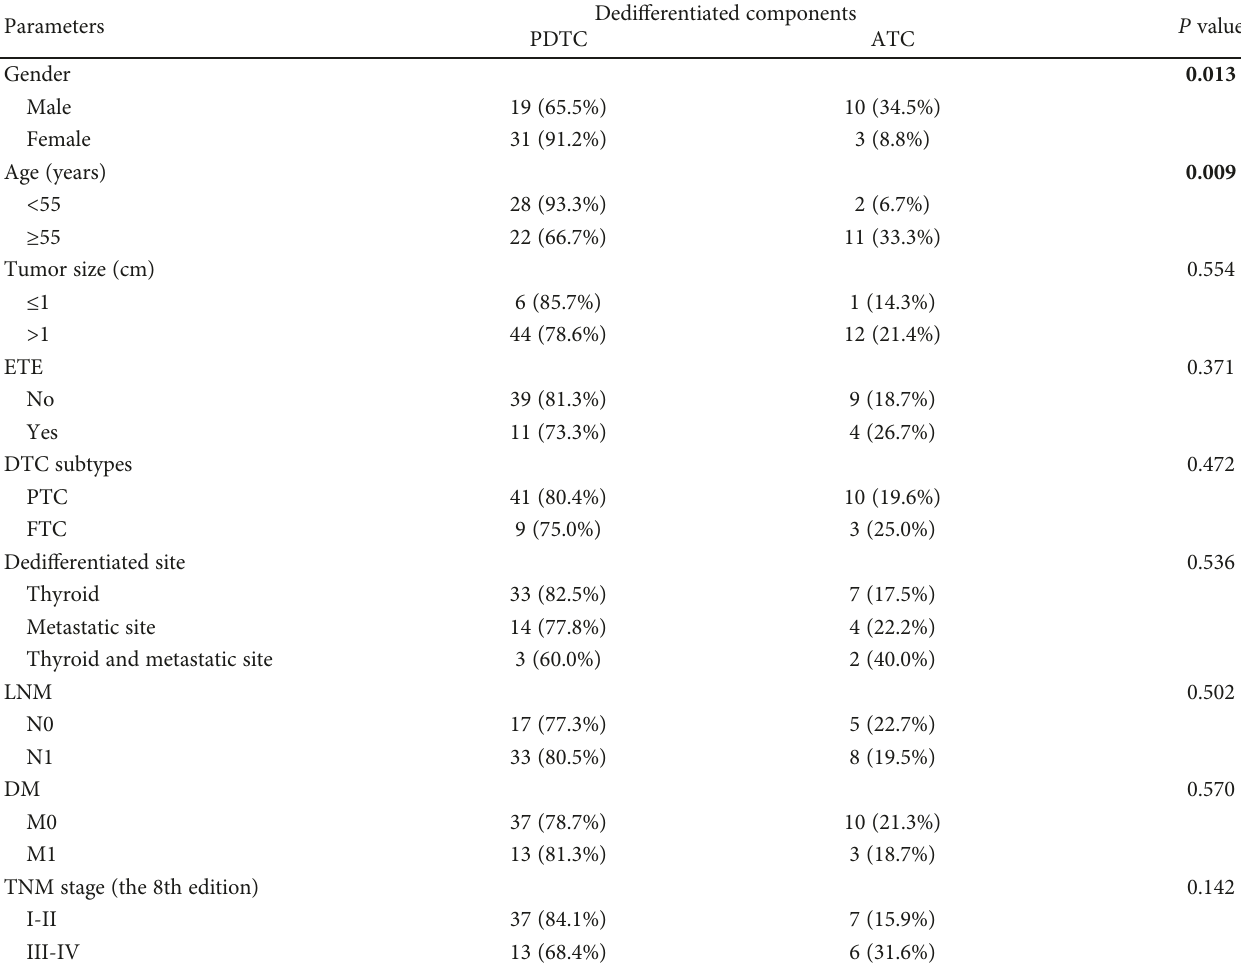
Table 5: Clinicopathological factors associated with dedi ff erentiated components.